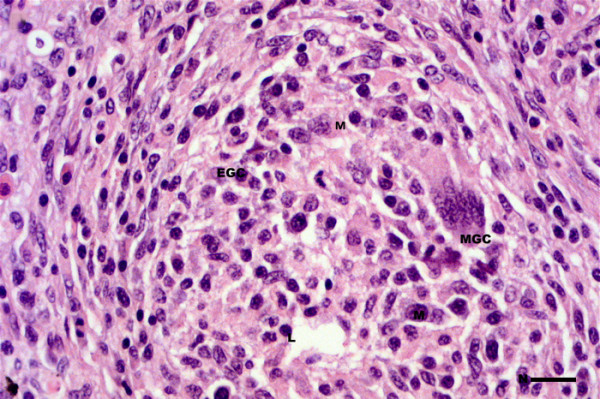
Cellular composition of severe vaccine granuloma of Atlantic salmon at 12 weeks following injection. Granulomas constitute of large macrophages (M), several lymphocytes (L), EGCs, and multinucleate cells (MGC). Bar = 15 μm.